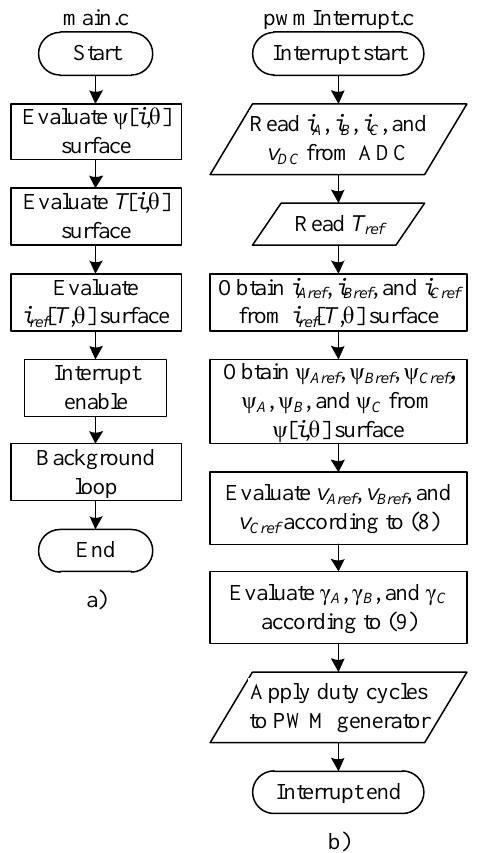
Figure6. Flowchartofthecontrolsystem: ( a )initializationprocedureandbackgroundloop, ( b )interrupt Figure 6. Flowchart of the control system: ( a ) initialization procedure and background loop, ( b ) with MPC interrupt with MPC strategy.